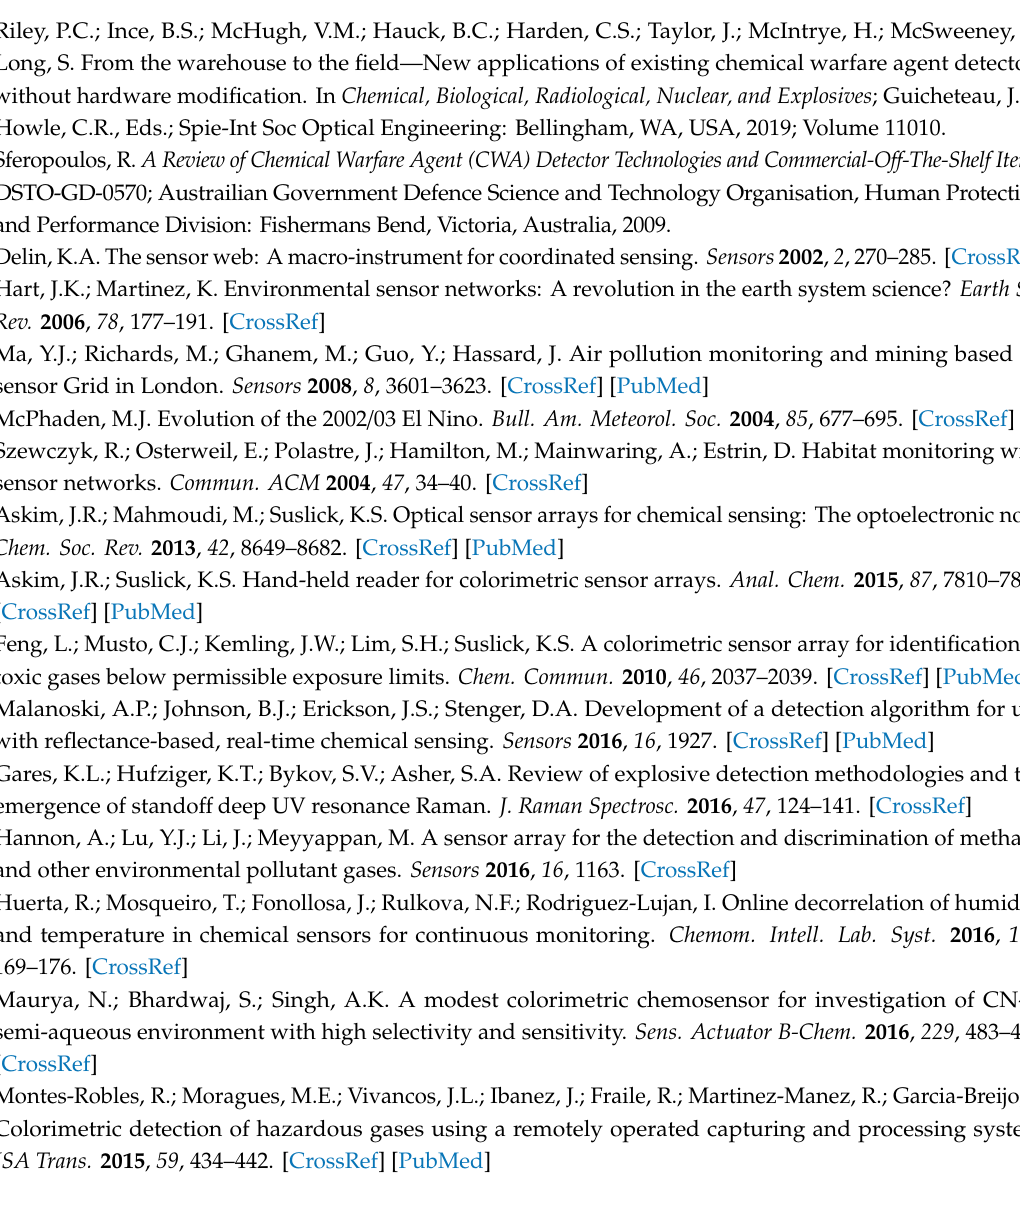
Figure S1: ABEAM-6 block diagram; Figure S2: Photos of ABEAM-6; Figure S3: ABEAM-15 block diagram; Figure S4: Photos of the ABEAM-15; details on the detection algorithm utilized, Figure S5: Algorithm